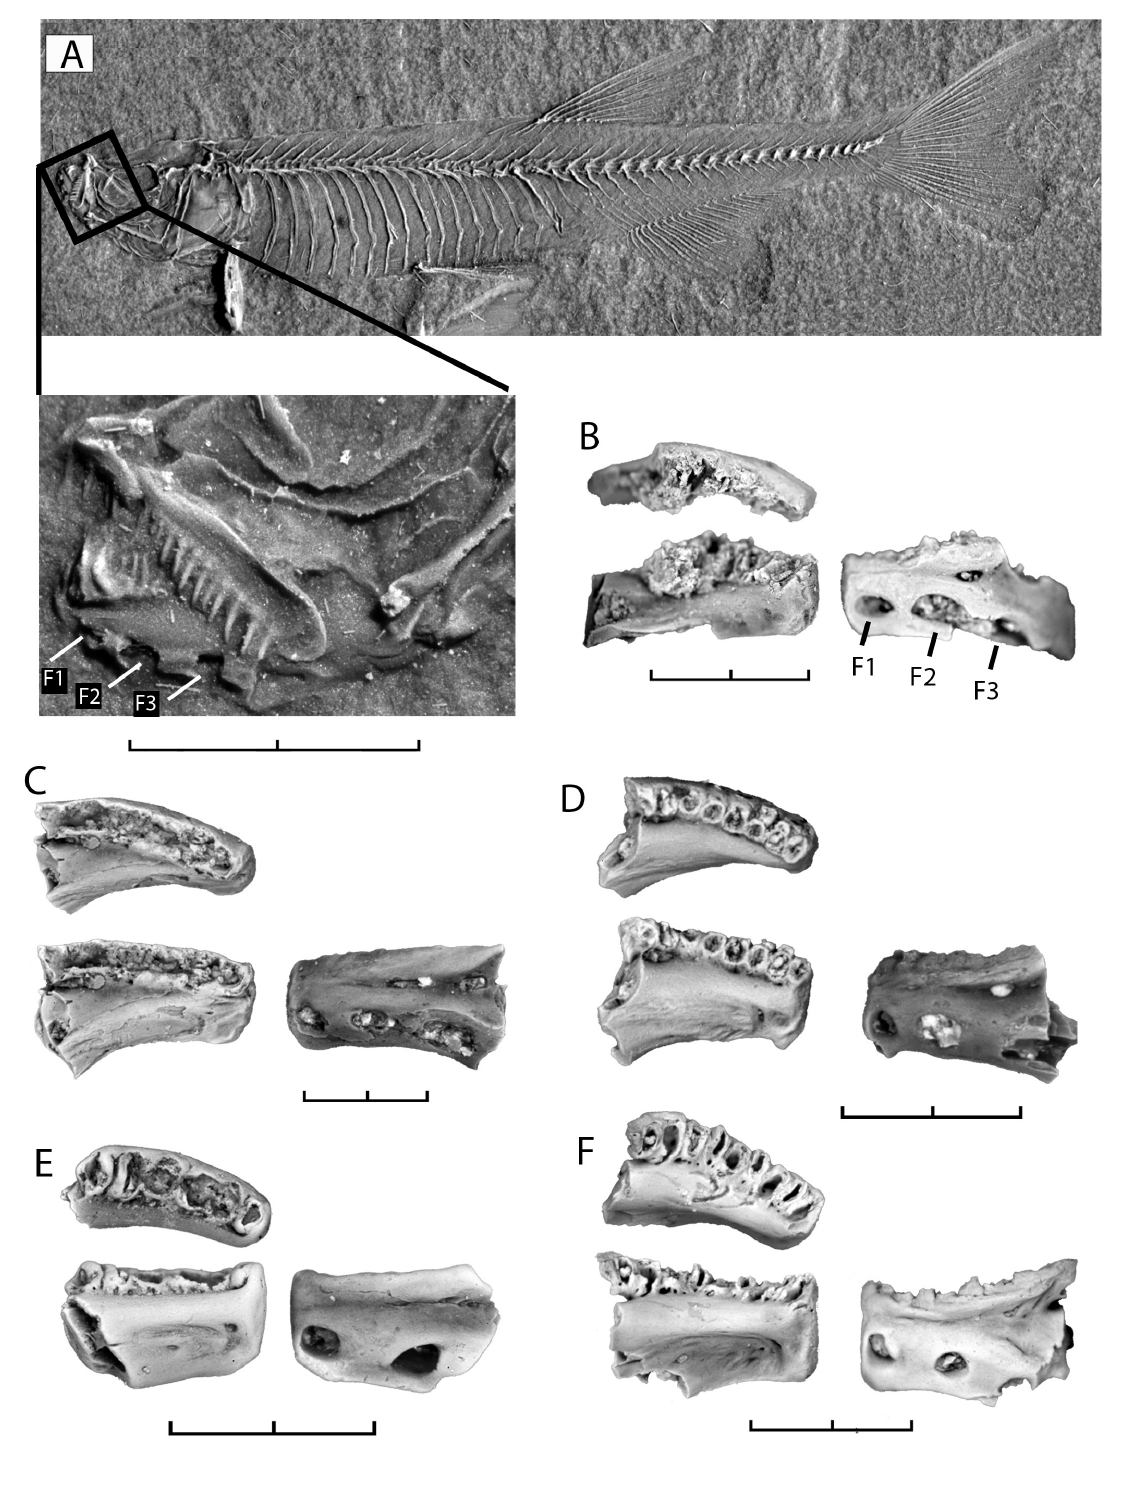
Figure 9. Ostariostoma sp. dentaries and maxilla from the Milk River Formation compared with the type specimen of Ostariostoma wilseyi and specimens from the late Campanian of Alberta and the late Maastichtian of Wyoming. A) Ostariostoma wilseyi skeleton with close-up of the skull showing dentary, and maxilla, photograph of UALVP 52610, cast of type specimen. B – D) dentary of Ostariostoma sp. from the Milk River Formation, showing variation in development of tooth row and sen - sory canal pores: B, UALVP 40928. C – D, both UALVP 56047. E) dentary of Ostariostoma sp. from the late Campanian Dinosaur Park Formation, TMP 2017.60.1. F) dentary of Ostariostoma sp. from the late Maastrichitan Lance Formation, UALVP 56053. Abbreviations: F1, foramen 1; F2, foramen 2; F3, foramen 3 of the sensory canal on the dentary. Scale bar equals 2